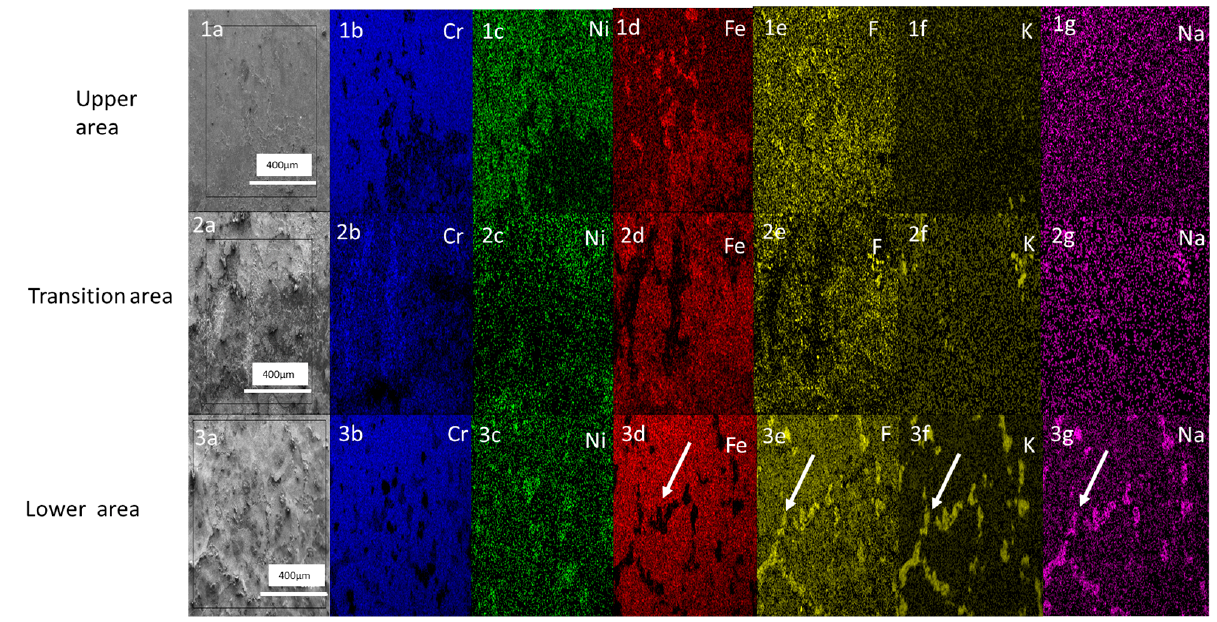
Figure 5. Surface elemental mapping of the SS316L test sample’s three areas. Images ( 1a – 1g ) show the elemental distribution of the upper area of the sample. Images ( 2a – 2g ) show the elemental distribution of the transition area. Images ( 3a – 3g ) show the elemental distribution of the lower area. The white arrows in the images 3d-3g show the grain boundary .